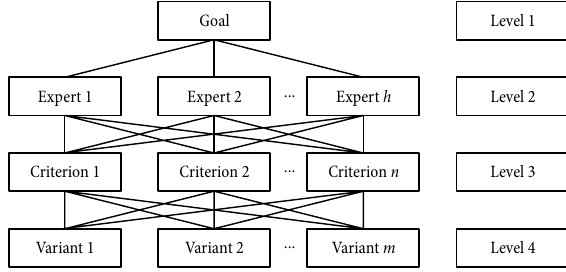
Fig. 5. The AHP method hierarchy